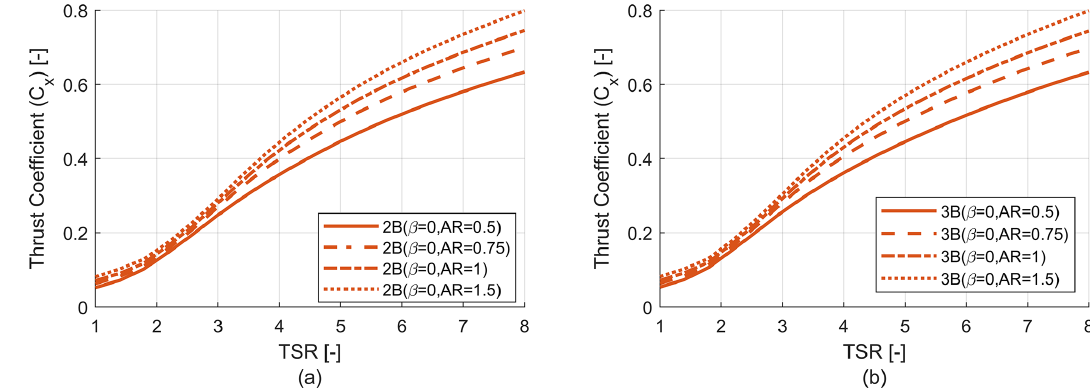
Figure 20. Thrust coefficient ( C x ) vs. TSR for different aspect ratio (AR) rotors.